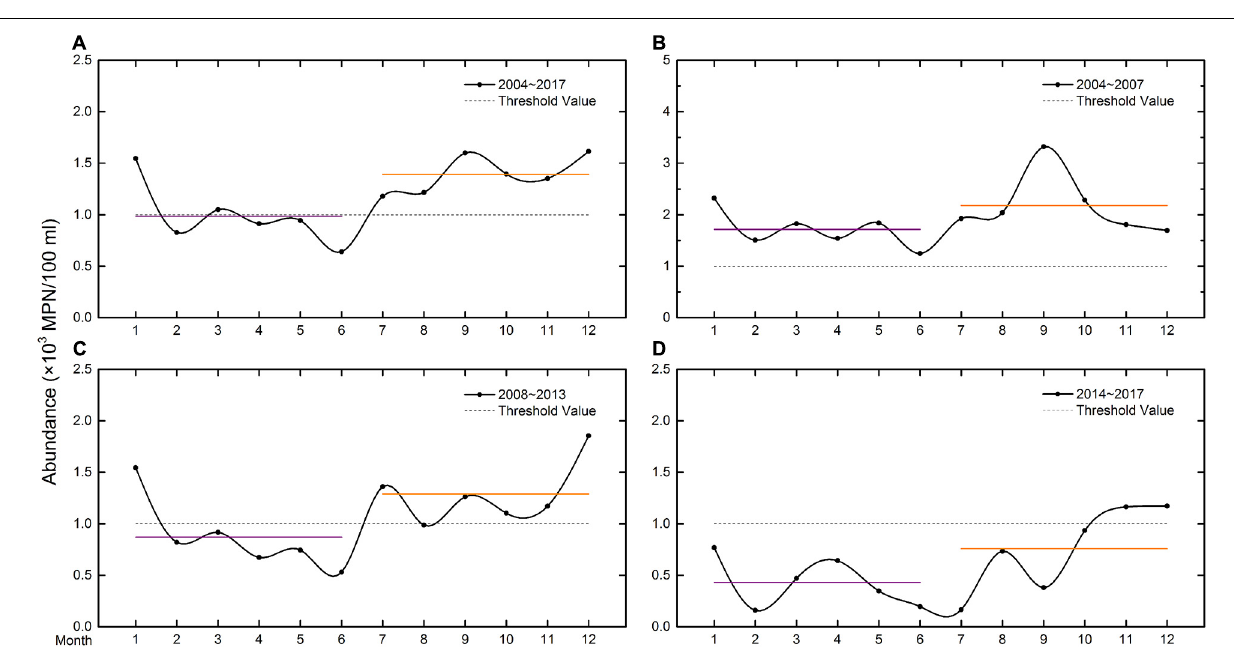
FIGURE 3 | Annual variation in the average abundance of CB ( × 10 3 MPN/100 ml) in Jiaozhou Bay: (A) from 2004 to 2017; (B) from 2004 to 2007; (C) from 2008 to 2013; and (D) from 2014 to 2017. The purple and orange lines represent average abundances in the first and second halves of the year, respectively. The dotted line (threshold value) represents the Class IV standard for CB abundance specified by the